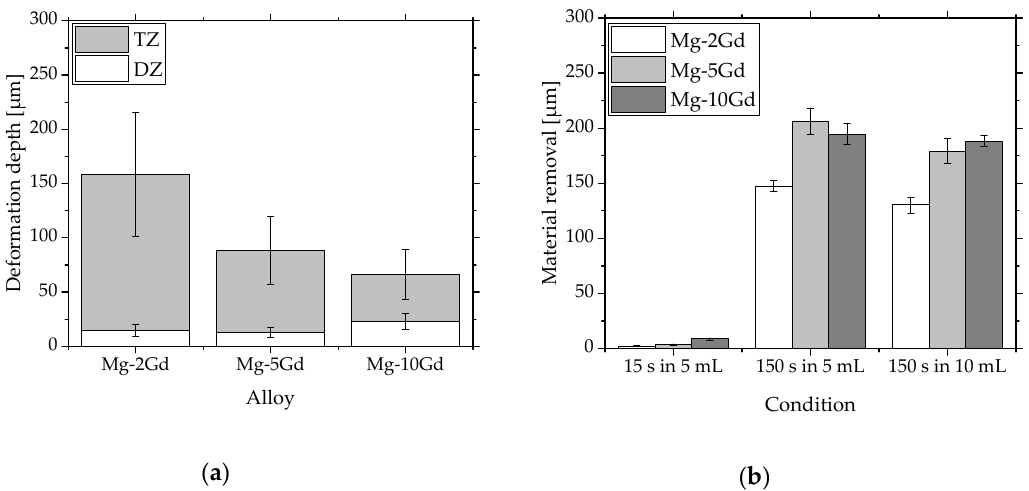
Figure 4. Diagrams of: ( a ) Mean value and standard deviation of DZ and TZ calculated for fifteen different regions per sample. Three samples per alloy were measured; ( b ) mean value and standard deviation of six samples for the amount of material removed from the Mg- x Gd alloys after each etching treatment. The material removal increases with higher Gd content for all etching conditions. For each alloy the material removal after etching for 150 s in 5 mL and 10 mL solution are comparable.